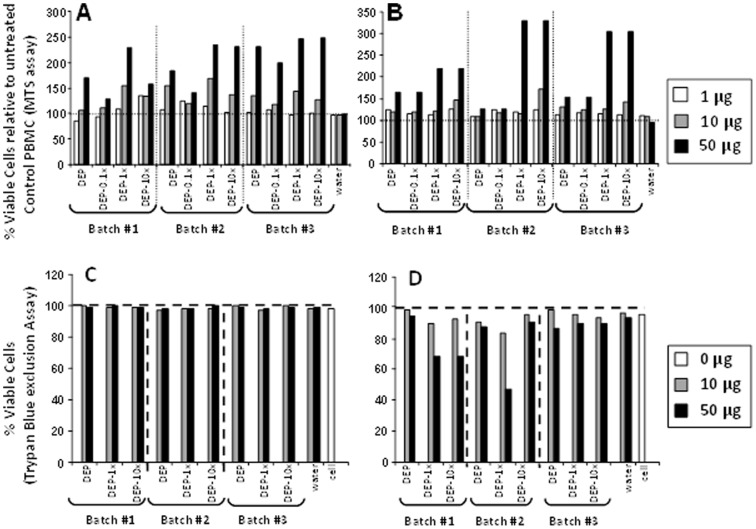
Effect of DEP and DEP-Env Exposure on the Viability of PBMC.Human PBMC (100, 000/well) from a healthy donor were exposed to indicated amounts of DEP, DEP-0.1x, DEP-1.0x, and DEP-10x from three independent batches for 4 (A) and 24 hours (B). Metabolic activity of cells (proportional to the number of viable cells) was evaluated by MTS assay (A, B). PBMC exposed to no particles served as controls. Percent (%) viability of PBMC exposed to DEP and DEP-ENV samples was expressed as the ratio of OD of samples to the OD of unexposed control PBMC x 100. Dashed horizontal lines indicate viability of unexposed PBMC (0 µg, control). Human PBMC (106/well) from a healthy donor were exposed to indicated amounts of DEP, DEP-0.1x, DEP-1.0x, and DEP-10x from three batches for 4 (C) and 24 hours (D). Numbers of live PBMC were counted with trypan blue and the percentage of viable trypan blue-excluding cells expressed as the ratio of live cells and the total number of cells (live and dead blue cells) x 100. Dashed horizontal lines indicate viability of unexposed PBMC (0 µg, control).